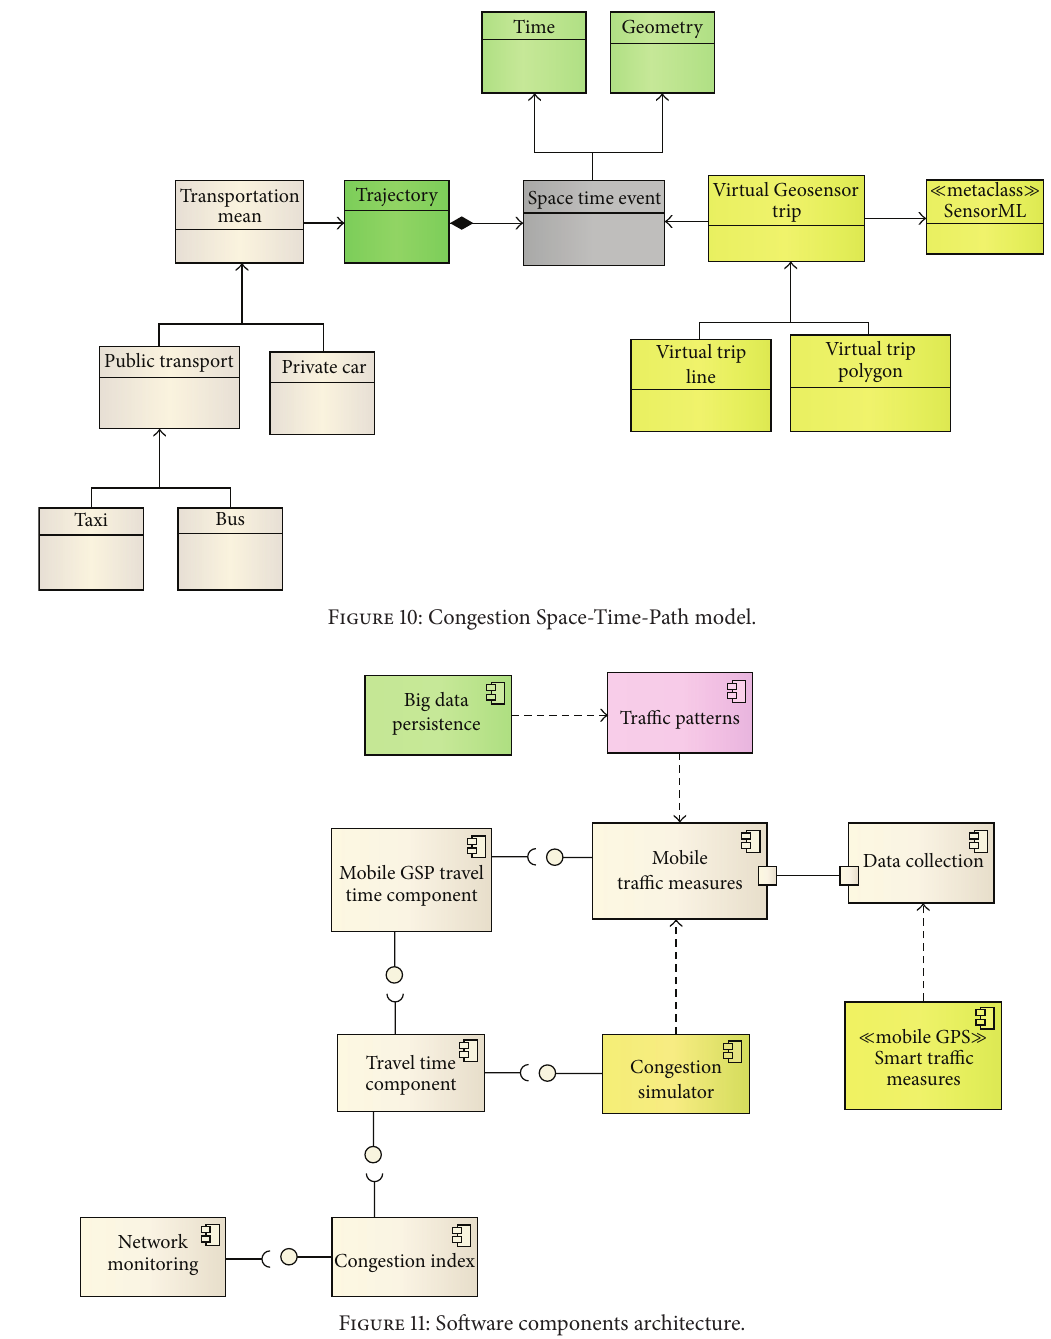
Figure 11: Software components